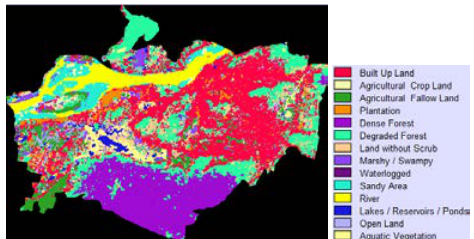
Figure 5: Predicted LULC of 2007 using all parameters / all suitibility